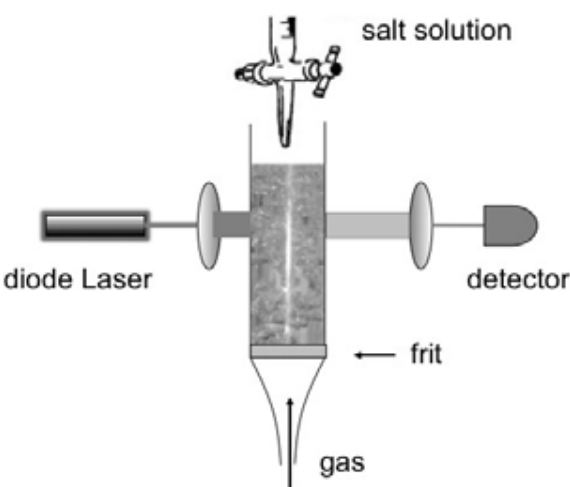
Figure 5. Scheme of the apparatus for producing bubbles and meas- uring their optical density. The gas is admitted from the bottom, passes through the frit and bubbles through the liquid contained in the chromatographic column. From the top more solvent or a salt solution can be added. Courtesy of Vincent S. J.